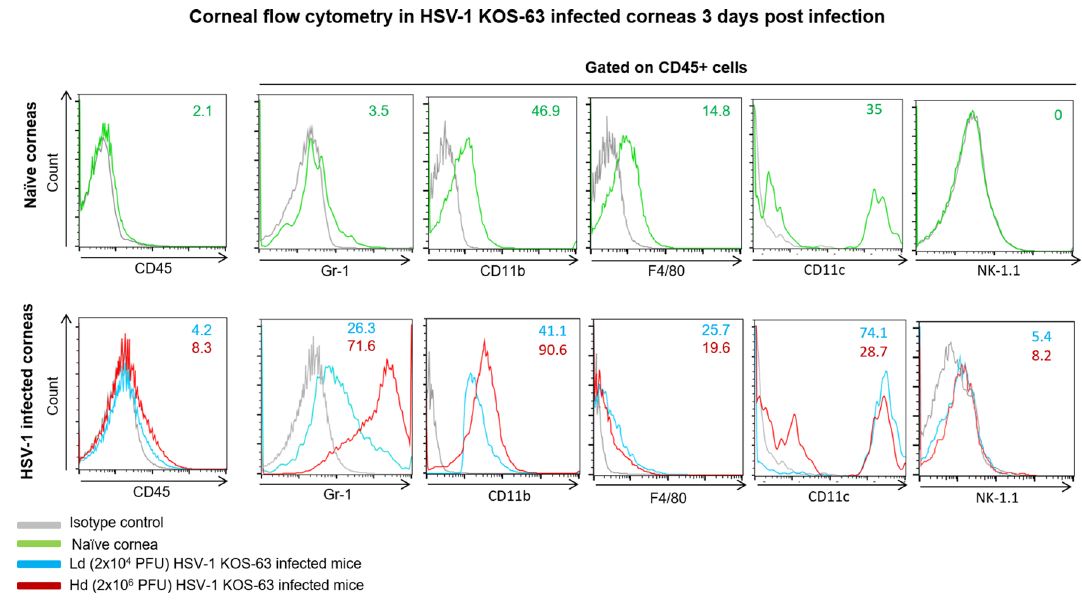
Figure 5. Flow cytometry histograms of Ld and Hd HSV-1 KOS-63-infected corneas at 3 dpi (lower row) compared with naïve corneas (upper row). Histograms are representative from 2 independent experiments. In one experiment corneas of 6 Hd- and 6 Ld-infected C57BL/6 mice were pooled and digested separately. In the other experiment 27 corneas of naïve C57BL/6 mice harvested and digested together in a same fashion. Single cell suspensions were stained for different cell markers. Gating was performed using isotype control antibodies. CD45 + population was selected in each group initially and percentage of CD45 + cells to the total number of cells is demonstrated in the histograms. Percentage of Gr-1 + cells, CD11b + cells, and F4/80 + were demonstrated after gating on CD45 + cell population. In the lower row blue line demonstrates the Ld and red line demonstrates the Hd HSV-1 KOS-63-infected mice. Gray line represents isotype control in all naïve corneas, while in the Ld and Hd infected corneas these cells constituted 5.4% and 8.2% of the CD45 + cells, respectively (Figure not shown). In summary, at 3 dpi the percentage of CD45 + cells was 2 times higher in the Hd-infected corneas as compared to Ld-infected. Moreover, gating on CD45 + cells, Gr-1 + , CD11b + , and NK cell percentage were higher in the Hd- versus Ld-infected corneas. Interestingly, CD11c + cells constituted majority of CD45 + cells in the Ld-infected corneas at 3 dpi and had higher percentage compared to Hd-infected (Fig. 5). Different immune cell subpopulation at 3 dpi in McKrae-infected corneas are demonstrated in Supplementary Fig. 3C. The majority of corneal immune cells in McKrae-infected corneas were Gr-1 + cells (48.2%). HSV‑1 KOS‑63 strain results in nerve damage after corneal inoculation. Figure 6A demonstrates representative confocal microscope micrographs of βIII-tubulin stained central and peripheral corneal nerves in naïve, sham-infected, and Hd or Ld HSV-1 KOS-63-infected mice. Total nerve density did not significantly decrease in sham-infected mice compared to naïve mice in either the central (94.72 ± 4.07 vs. 119.46 ± 0.58 mm/ mm 2 ; p = 0.23) or peripheral corneas (79.12 ± 7.70 vs. 105.28 ± 8.61 mm/mm 2 ; p = 0.39). At 1 dpi, there was no significant loss of nerves in the central cornea of Ld KOS-63-infected mice, as compred to sham-infetced mice. However, the central corneal nerve density significantly decreased at 3 and 7 dpi for the Ld and for all time- points for the Hd KOS-63-infected mice, as compared to sham-infected ( p < 0.05) (Fig. 6B). As early as 3 dpi, the central corneal nerve density was significantly lower in the Hd compared with Ld KOS-63-infected mice (16.79 ± 3.17 vs. 57.41 ± 14.64 mm/mm 2 , respectively; p = 0.004) (Fig. 6B). Peripheral corneal nerves further decreased significantly at 7 dpi in the Ld KOS-63-infected mice (30.87 ± 3.61 mm/mm 2 ) compared to sham- infected ( p = 0.005). Morevoer, in the Hd KOS-63-infected corneas, peripheral corneal nerves decreased signifi- cantly at 3 dpi (33.48 ± 12.99 mm/mm 2 ) and 7 dpi (12.79 ± 8.55 mm/mm 2 ) compared to sham-infected ( p = 0.01 and p < 0.0001, respectively) (Fig. 6C). Interestingly, there was no significant difference in peripheral corneal nerve density between the Ld and Hd KOS-63-infected groups (Fig. 6C). However, we did observe a linear decrease in the central and peripheral corneal nerve densities during the 7 days follow-up period in both Ld and Hd KOS-63-infected mice (ANOVA: p < 0.0001). Similar to Hd KOS-63-infected corneas, central corneal nerve density was significantly reduced at 1 dpi in Hd McKrae-infected corneas (62.20 ± 4.32 mm/mm 2 ), as compared to naïve and sham-infected controls. ( p = 0.0003 and p = 0.02, respectively (Supplementary Fig. 4). Additionally, corneal esthesiometry confirmed significantly decreased corneal nerve sensitivity, starting from 5 dpi in both Ld and Hd HSV-1 KOS-63-infected corneas. At 5 dpi corneal nerve sensitivity was significantly lower in the Hd-infected corneas, as compared to Ld-infected corneas (filament length of 0.77 ± 0.37 cm vs. 4.23 ± 0.26 cm; p < 0.0001). Similarly, at 7 dpi, corneal nerve sensitivity was significatly lower in the Hd-infected corneas as compared to Ld-infected corneas (filament length of 0.0 ± 0.0 cm vs. 1.73 ± 0.61 cm; p = 0.007) (Fig. 7).